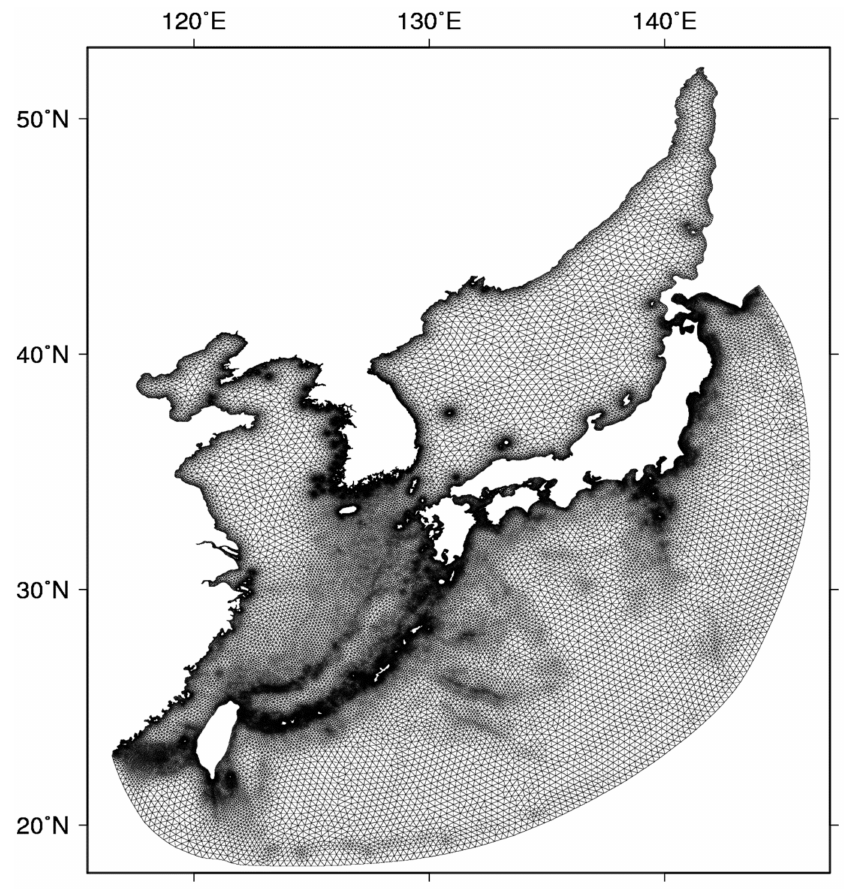
Figure 3. Domain area and grids used for the simulation of